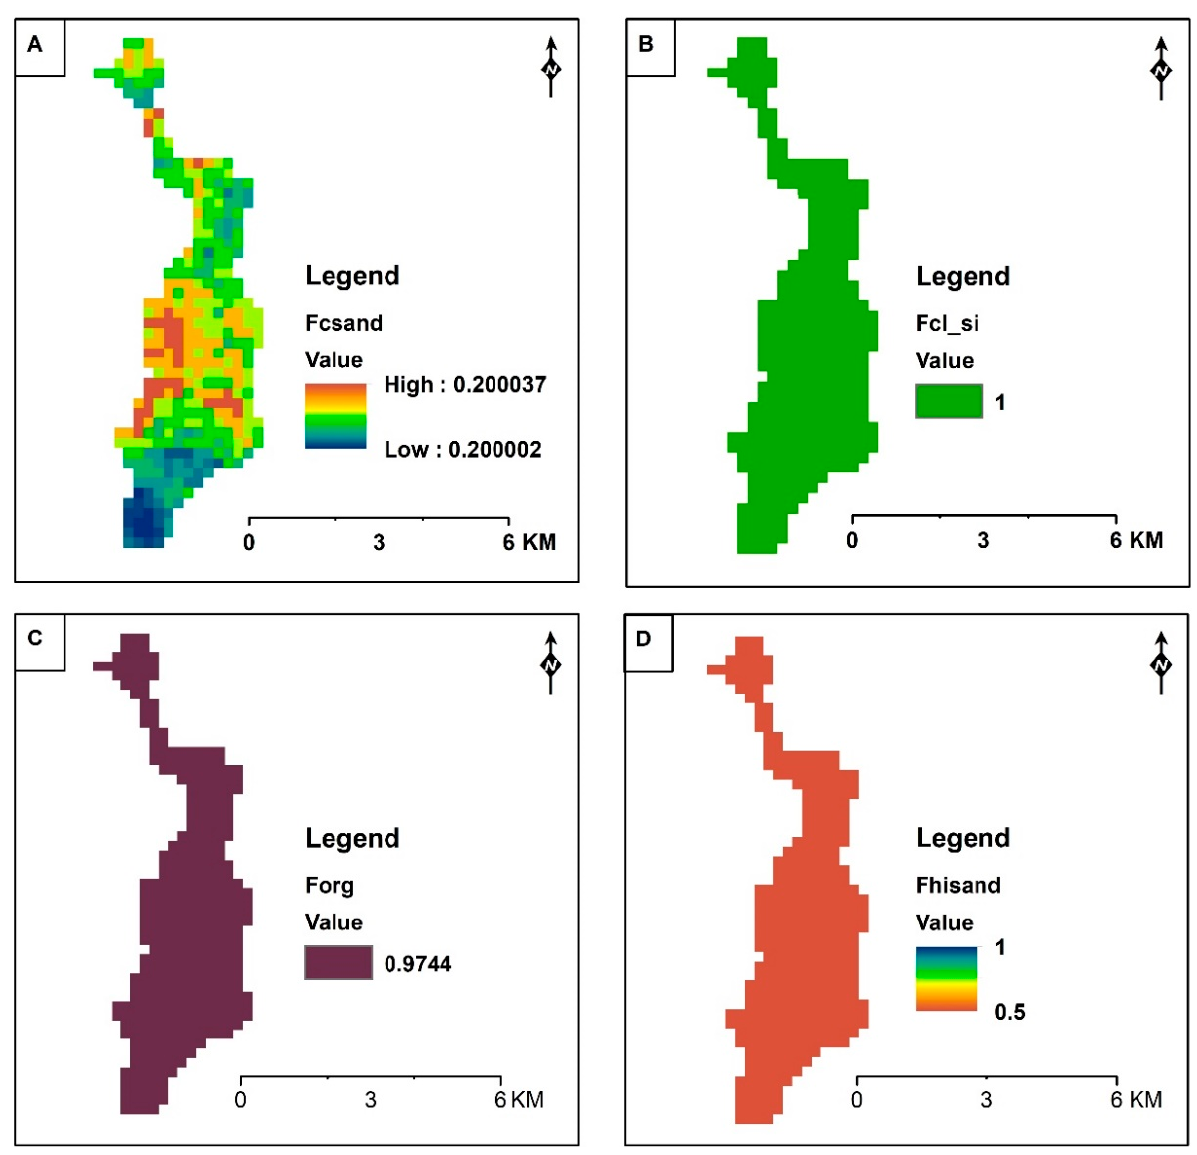
Figure 5. Physical and chemical properties of the soil in the study area. ( A ): Coarse sand content; ( B ): clay-to-silt ratio; ( C ): organic carbon content; ( D ): high sand content. Source: Data from the International Soil Reference and Information Centre (ISRIC). Available online at: https://data.isric.org/geonetwork/srv/eng/catalog.search#/home (accessed on 3 October 2019)